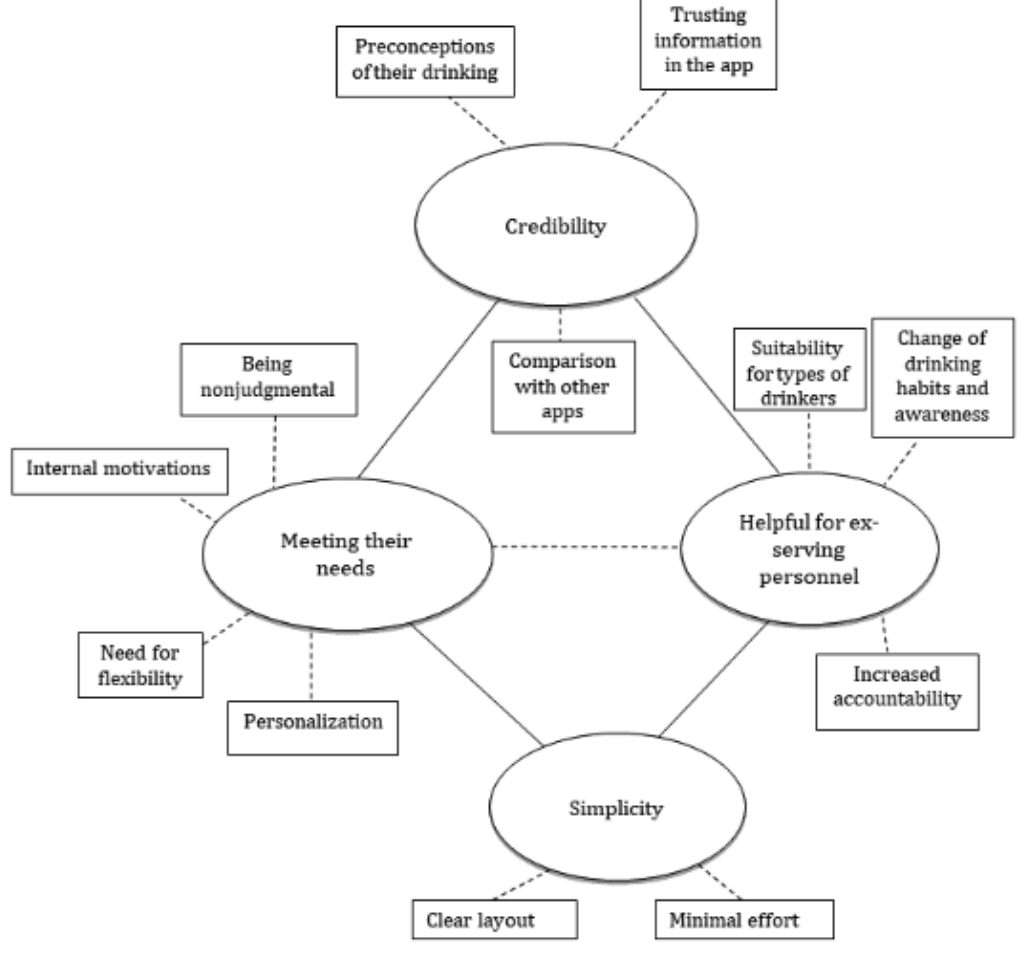
Figure 2. Thematic map overview of themes and